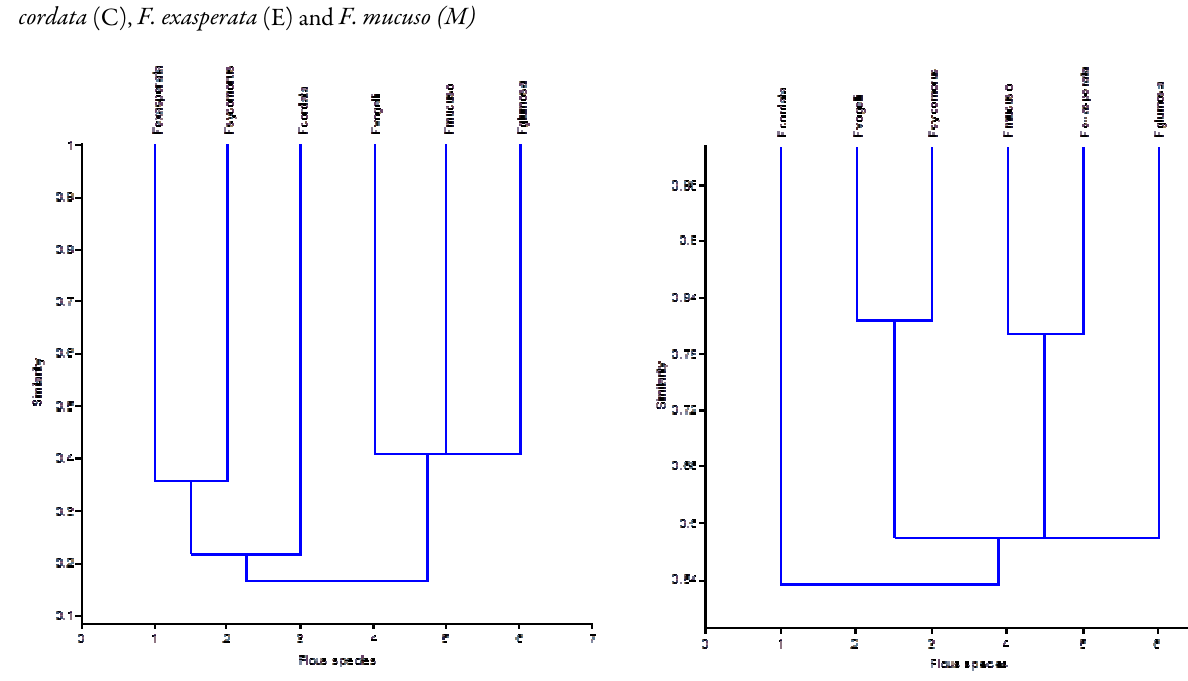
Fig. 2a. Dendrogram showing the chemotaxonomic relationship among six Ficus species from ethanolic extracts